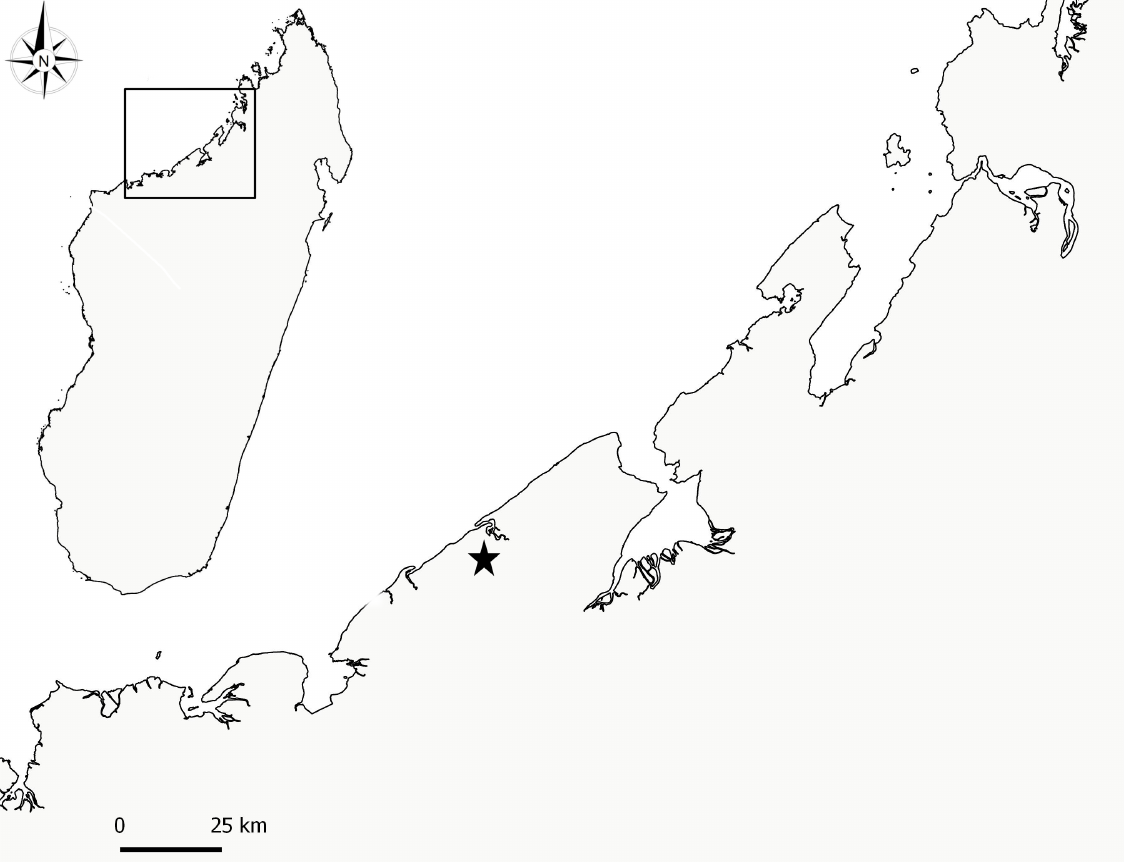
Fig. 1. Type locality of Ocyale ghost Jocque M. & Jocqué R. sp.